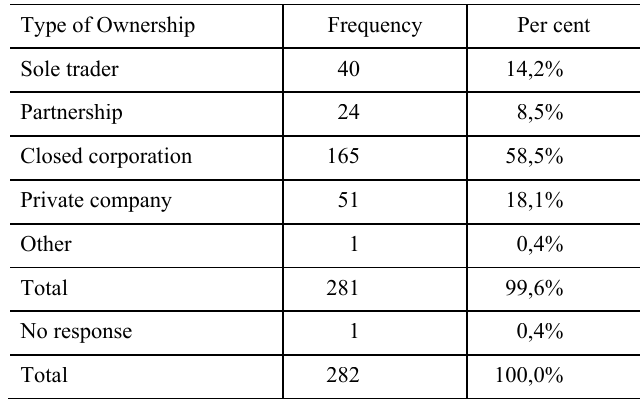
Table 5: Form of business ownership